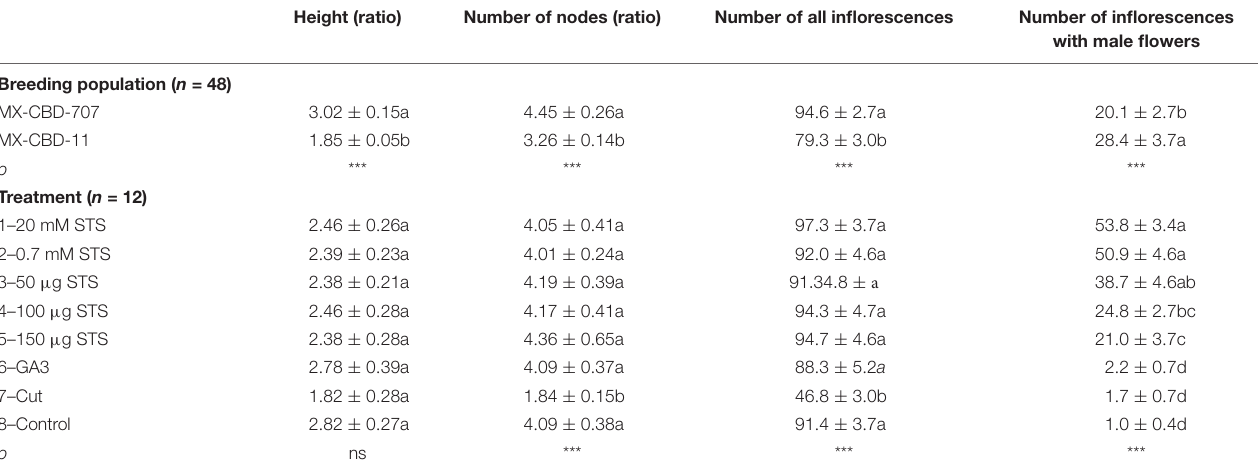
TABLE 3 | Influence of breeding population and treatment on the ratio of plants height, the ratio of the number of nodes, number of all inflorescences, and number of male inflorescences. Height (ratio) Number of nodes (ratio) Number of all inflorescences Number of inflorescences